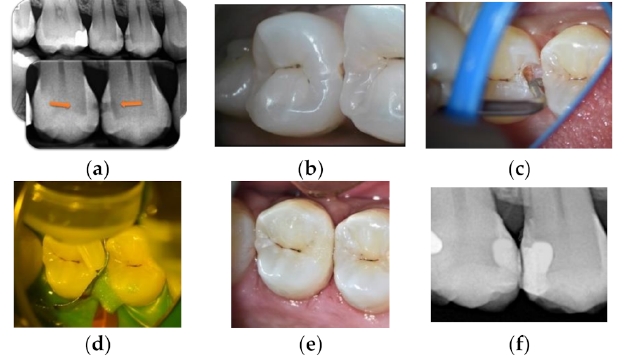
Figure 5. Mineral alkasite-enriched composite obturation: ( a ) pre-operative radiograph; ( b ) cavitation visible after cleaning steps; ( c ) sonic curved insert; ( d ) Cention ® injection; ( e ) final view in daylight; ( f ) post-operative